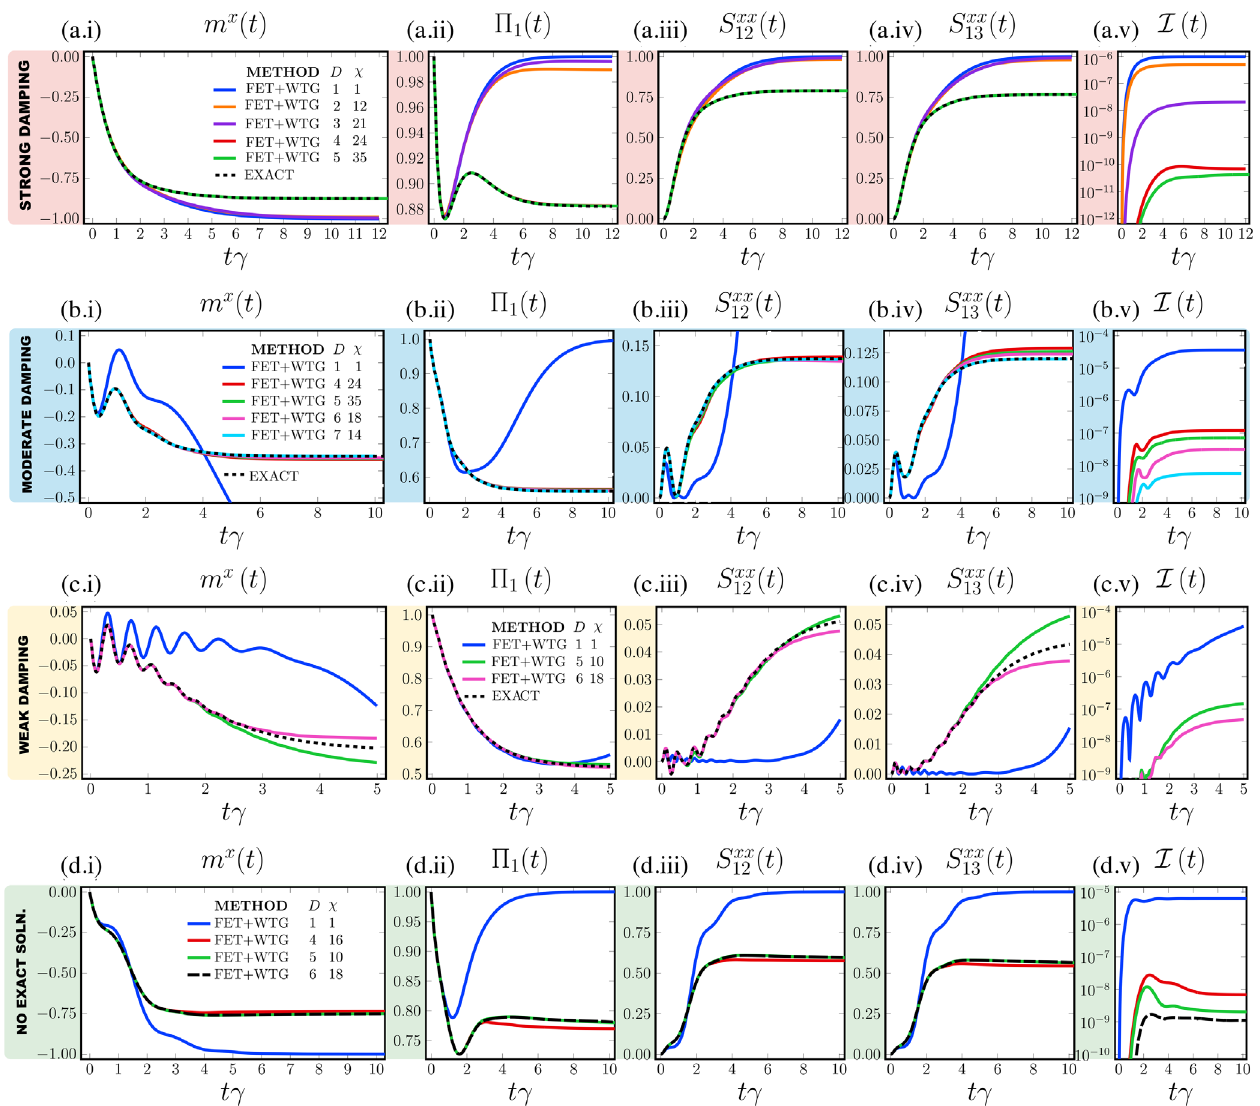
= γ ¼ 0 in (a) strong ( V= γ ¼ 0 . 2 ), (b) moderate ( V= γ ¼ 1 . 2 ), and (c) weak FIG. 4. Dynamics of the dissipative Ising model for h x ( V= γ ¼ 4 . 0 ) spin-damping regimes calculated using FET þ WTG for a range of bond dimensions D and superimposed with results = γ ¼ 1 . 0 ) but that calculated using the EXACT method. (d) Results for a regime not applicable to the EXACT method ( V= γ ¼ 0 . 5 and h x can be treated with FET þ WTG. In each case, we plot (i) the magnetization m x ð t Þ , (ii) the average purity Π 1 of the single-site reduced density matrices, (iii) the nearest-neighbor S xx 12 , (iv) the next-nearest-neighbor S xx 13 spin-spin correlations, and (v) the average infidelity of truncation I ð t Þ at each time